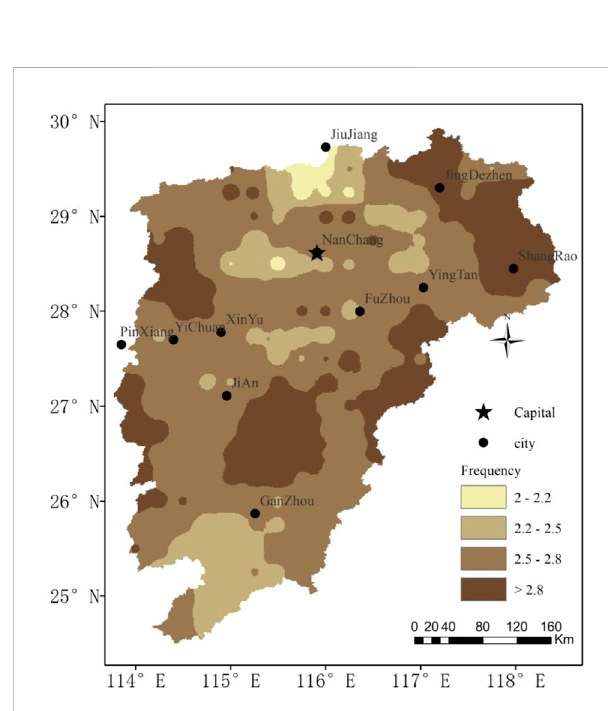
(Figure 7), various regions of the basin were affected differently by extreme precipitation events. The high-value centers (annual occurrence frequency: ≥ 2.8) were located mainly in the eastern and western border mountain areas and in the central mountains, consistent with the distribution of high-elevation terrain (Figure 1). The low-value areas were distributed in northern and southern parts of the basin. Thus,